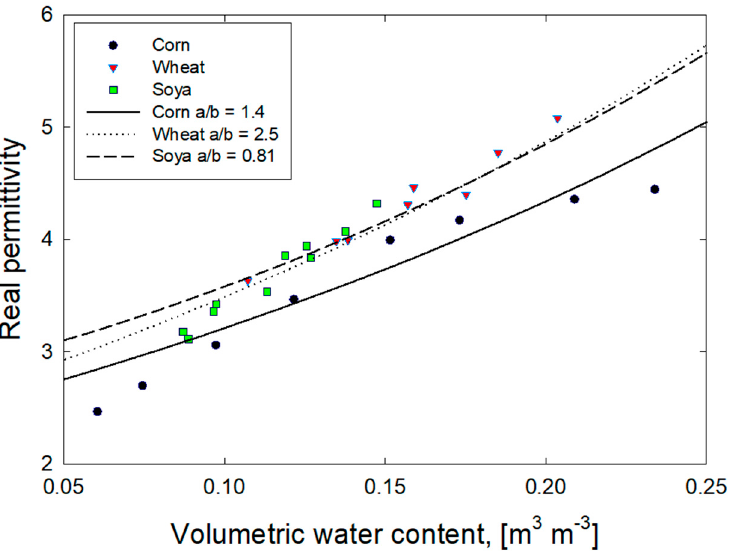
Figure 11. Measured real permittivities in corn, wheat and soya (digitized from [12]) with model predictions using aspect ratios shown and other parameters listed in Table 8.